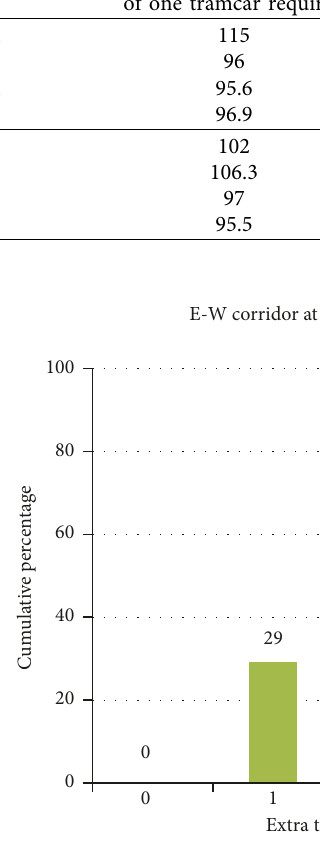
Figure 5: Histogram representation of the corresponding extra tram car required at Haya Hulet 1